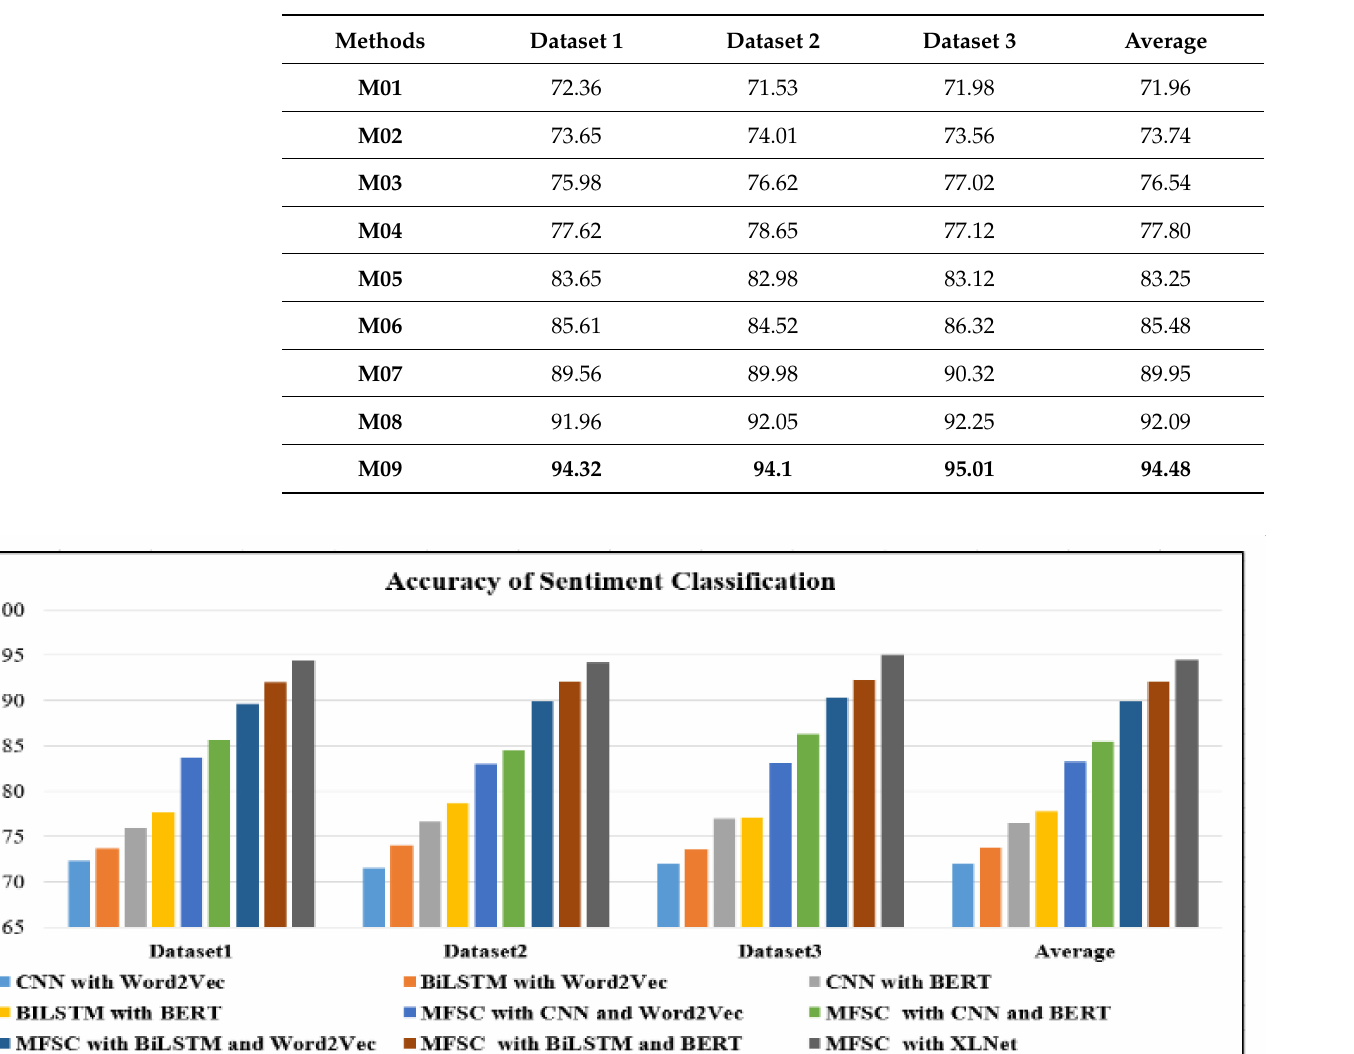
Table 12. Sentiment classification accuracy (%) results using the MFSC model.